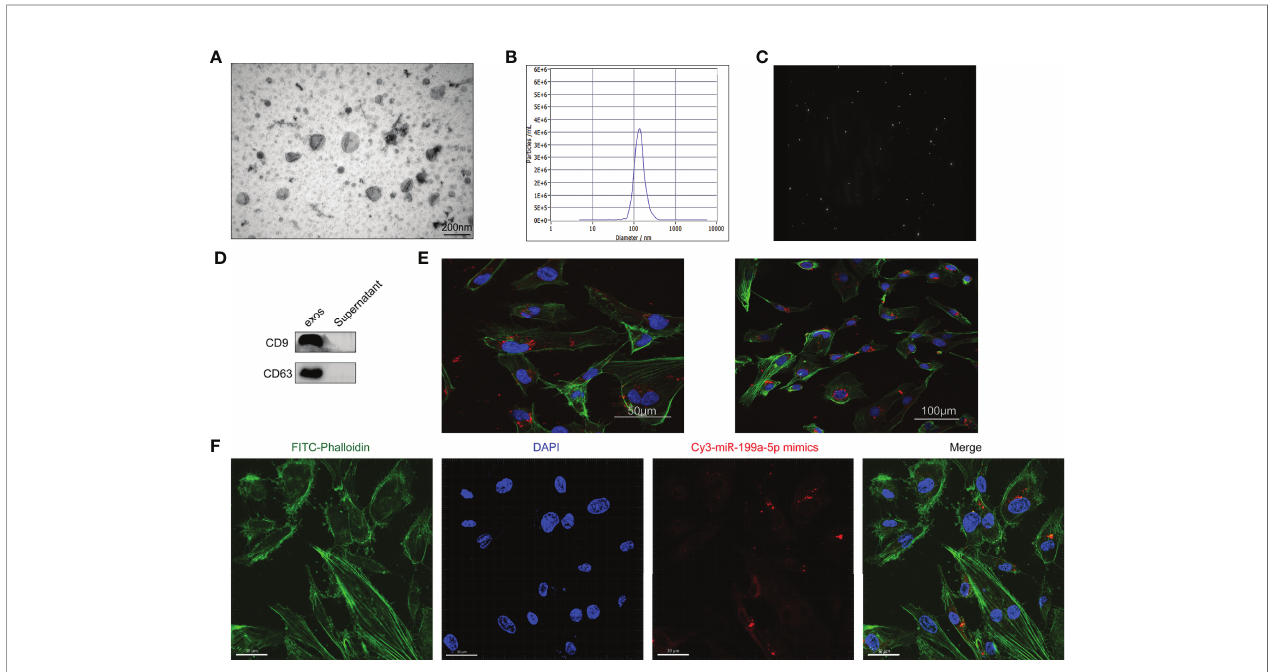
FIGURE 3 | Characterization of Exosomes. (A) The morphology of HOS-Exosomes shown by TEM. (B) The particle size distribution in puri fi ed Hos-exosomes determined by NTA (nanoparticle tracking analysis). (C) , Image of the puri fi ed exosomes. (D) The surface markers (CD9 and CD63) of exosomes were detected by western blotting. (E) Laser scanning confocal microscopy analysis of PKH26 ‐ labeled Hos-exosomes internalization by HUVECs. The red ‐ labeled exosomes were visible in the perinuclear region of recipient cells. (F) Laser scanning confocal microscopy analysis of HOS-exosomal miR-199a-5p-mimics-cy3 internalization by